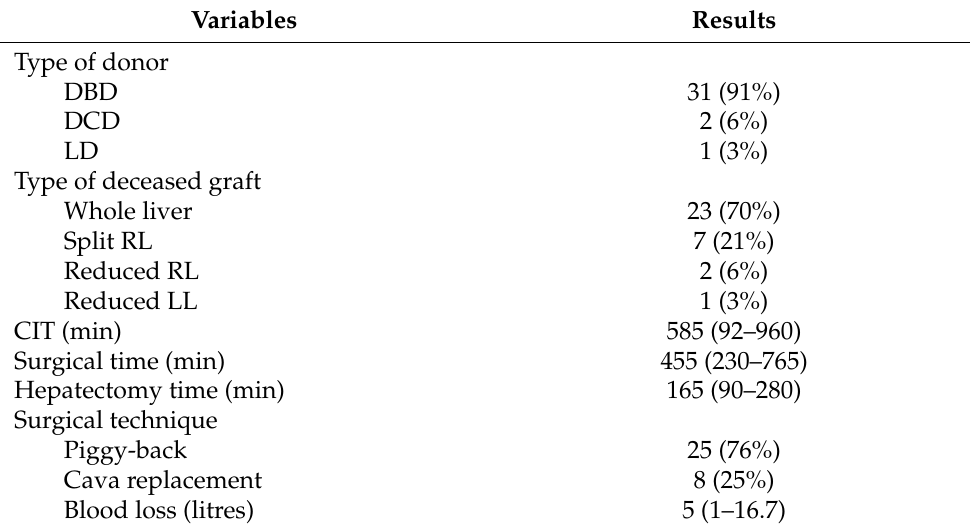
Table 2. Donor characteristics and surgical